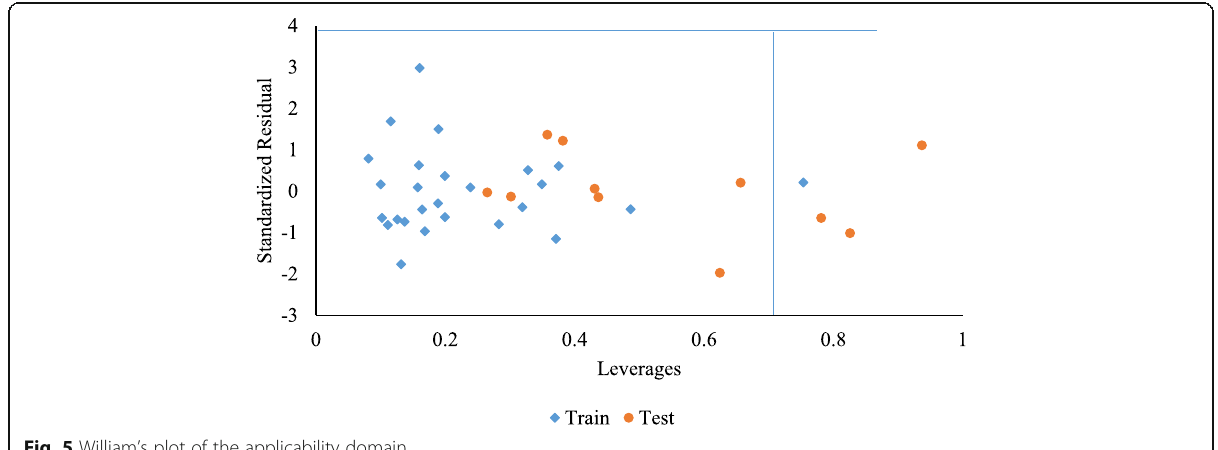
Fig. 5 William ’ s plot of the applicability domain